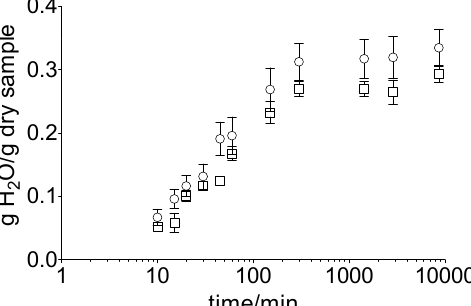
Figure 2. Water content of the hoof membrane over 120 h, depending on the incubation medium, water (o) or gel ( □ ), obtained by gravimetric measurements. Mean value ± standard deviation, n = 6.